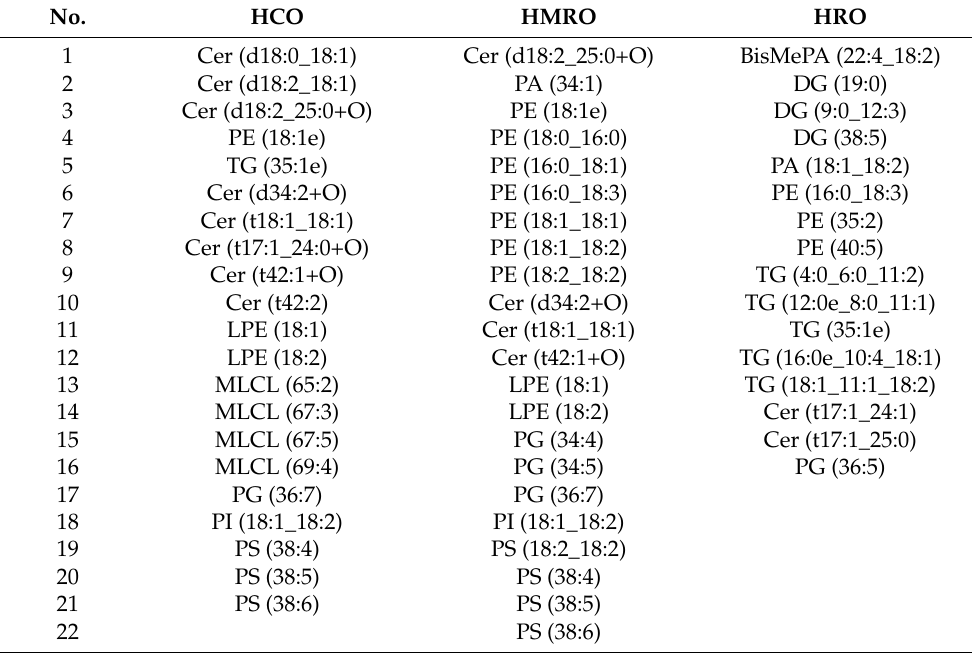
Table 4. Lipids disappeared after the heating process in three kinds of camellia oil.